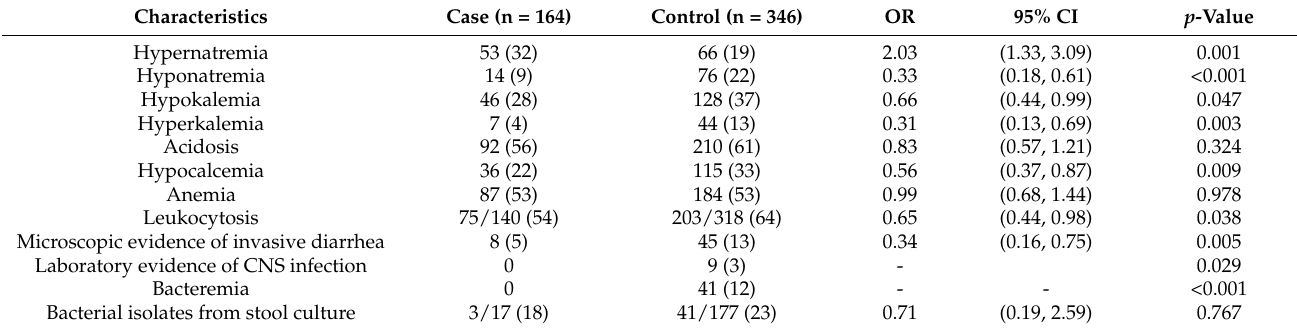
Table 2. Laboratory characteristics of critically ill ICU children aged below five years without (cases) and with antibiotic therapy (controls) in